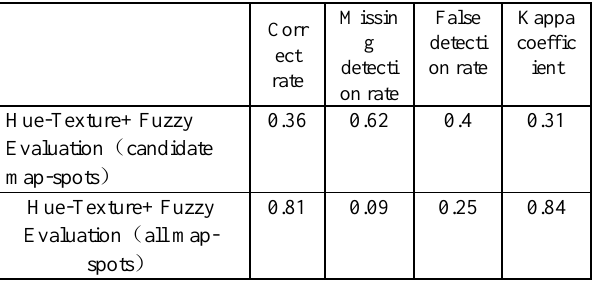
Table 2. Influence of Levene-Test on Detection